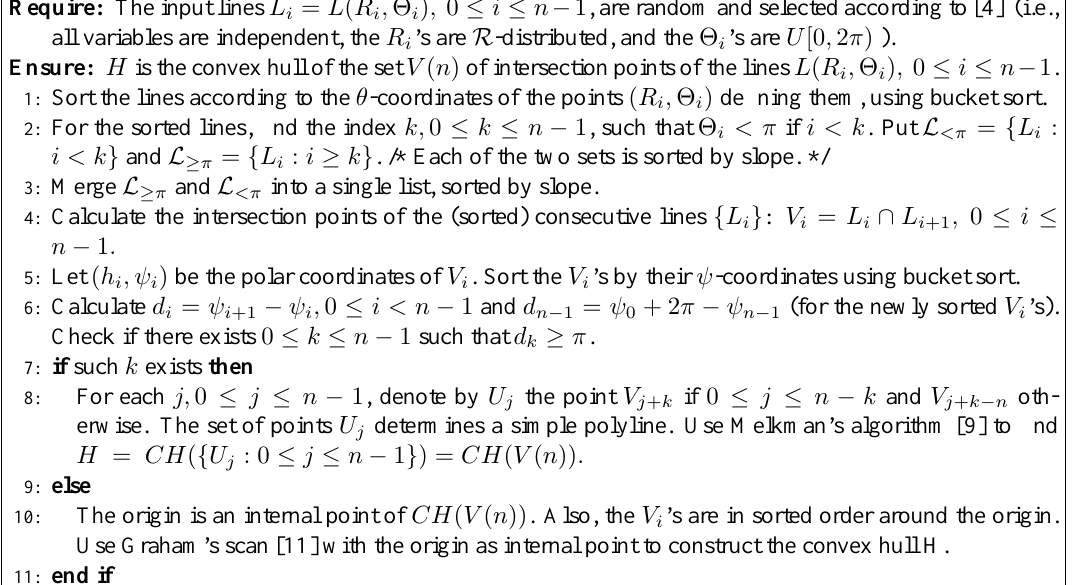
Algorithm 1: C ONVEX HULL FOR INTERSECTIONS OF RANDOM